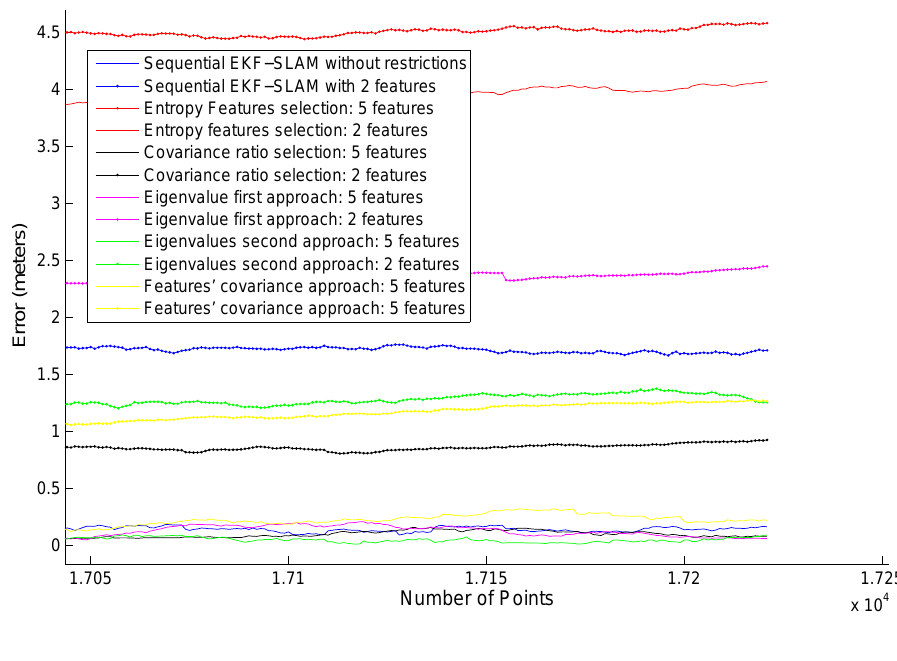
Figure 11. Zoom of Figure 10. As it can be seen, the paths estimated by the entropy approach is the worst estimated